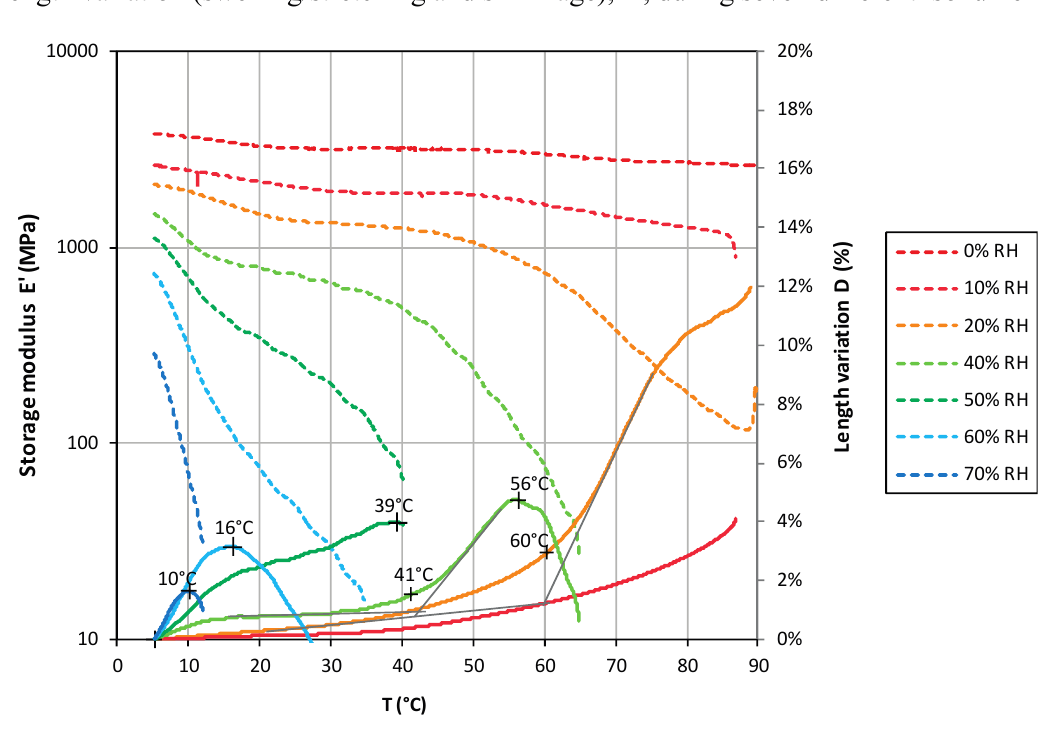
Figure 6. Storage modulus ( E ') and variation in sample length ( D ) vs. T , at 0%–70% RH, for 0.04–0.05 mm CaCas/Gly films. The dashed line represent E '; solid lines represent D